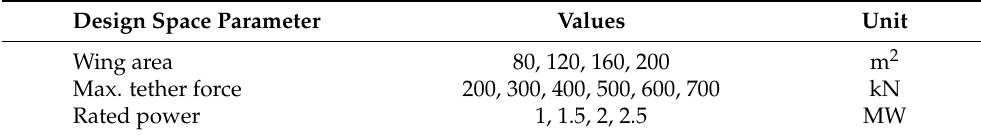
Table 2. System design